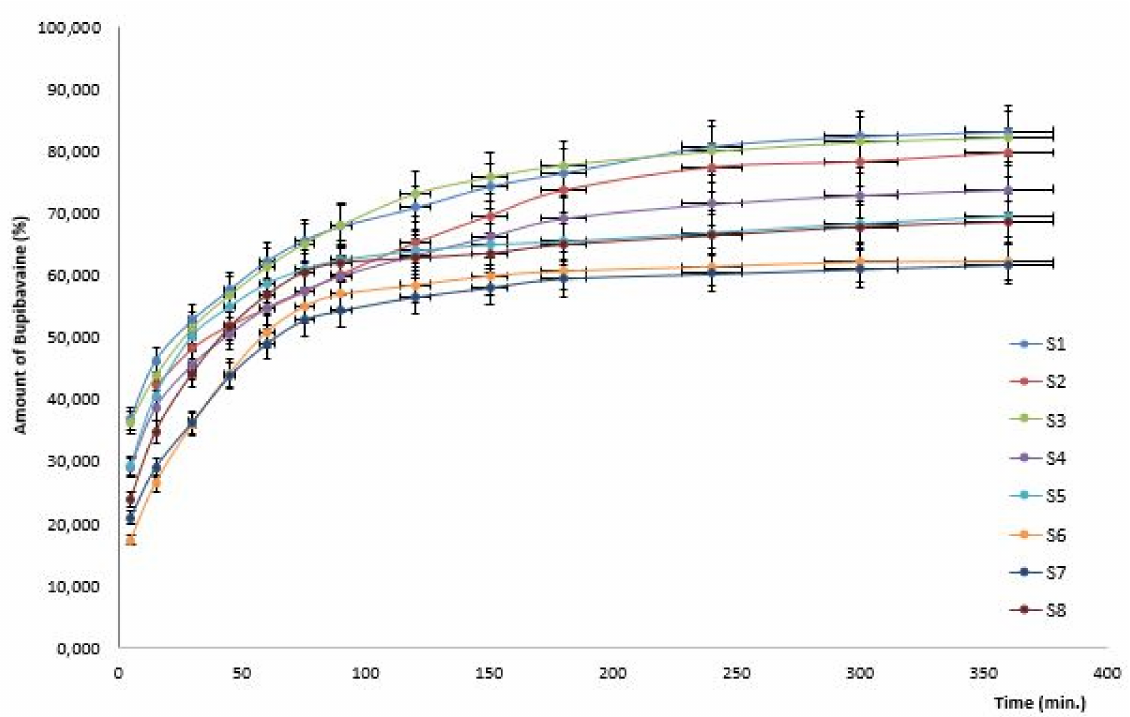
Figure 7. Cumulative release profiles for colloidal systems analyzed at 35 ◦